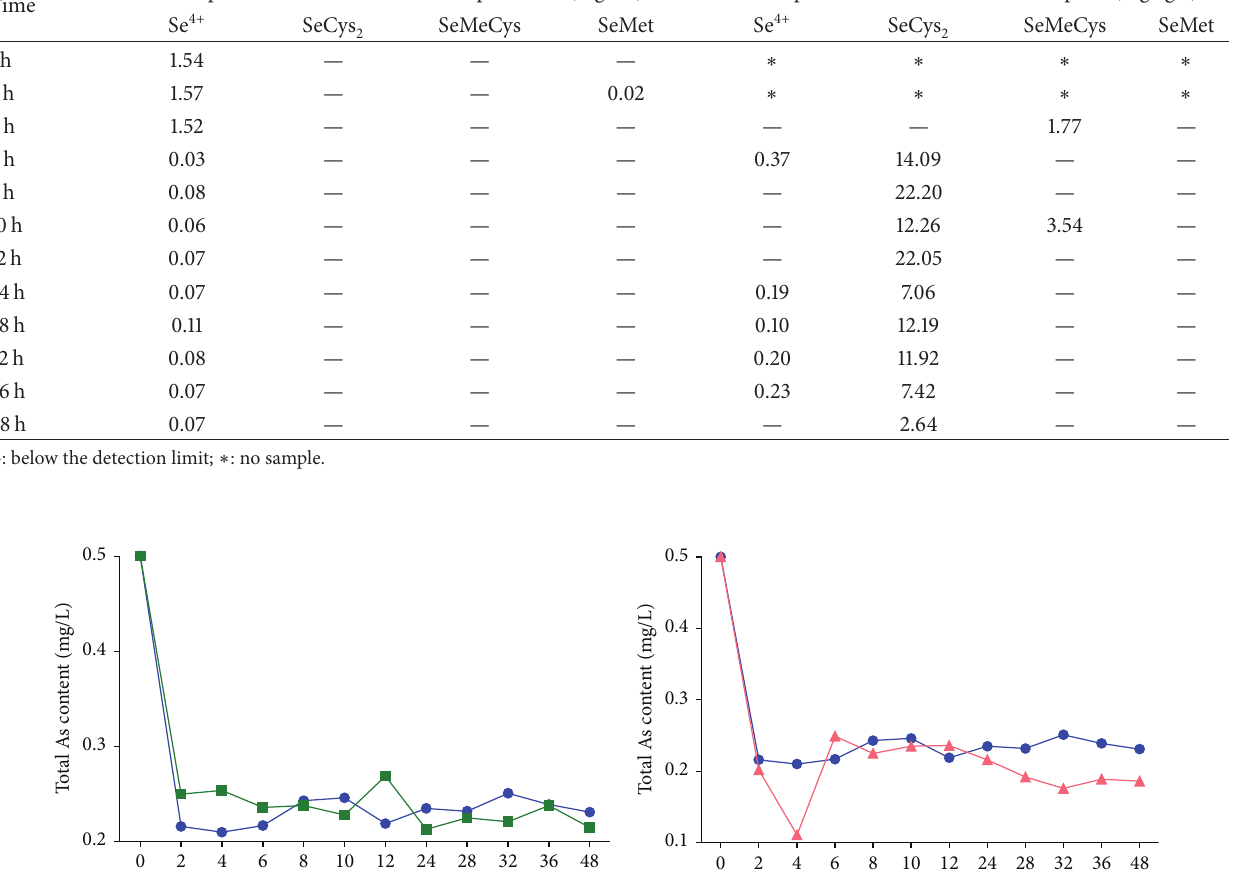
, SeMecys, and SeMet) in the supernatant and deposit. (The isolated strain, Suzhou 2